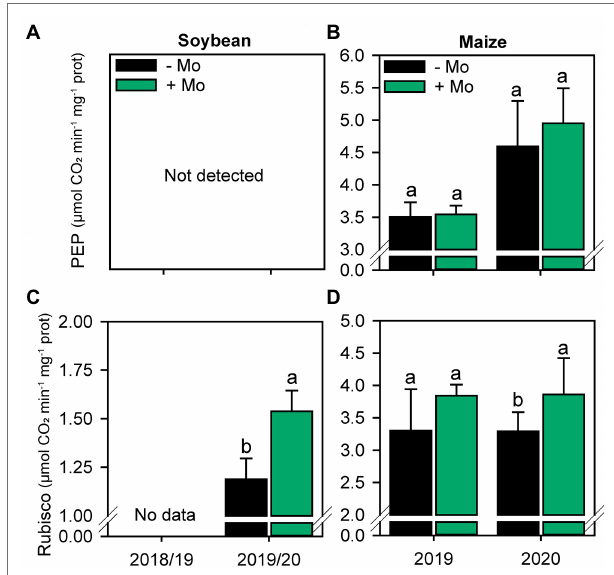
FIGURE 3 | Activity of PEP Carboxylase (A,B) and Rubisco (C,D) enzymes of soybean and Maize plants under the effect of the presence or absence of foliar application of Mo. Different lowercase letters represent statistical difference between treatments (presence or absence of Mo) according to the F test ( p ≤